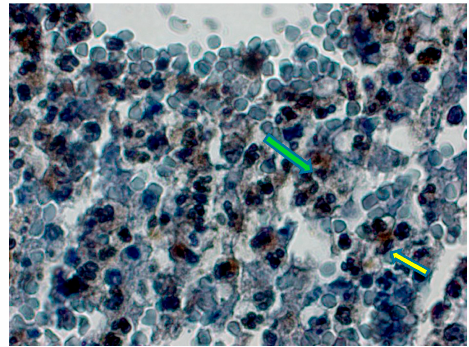
Figure 2. Type 2 diabetic group, vacuolar structures in some leukocyte cells, moderate Bcl-2 expression (yellow arrow), pyknosis in nuclei were observed. Bcl-2 expression and apoptotic changes (green arrow) in nuclei of some lymphocytes. Bcl-2 immunochemistry staining, bar 50 µm.